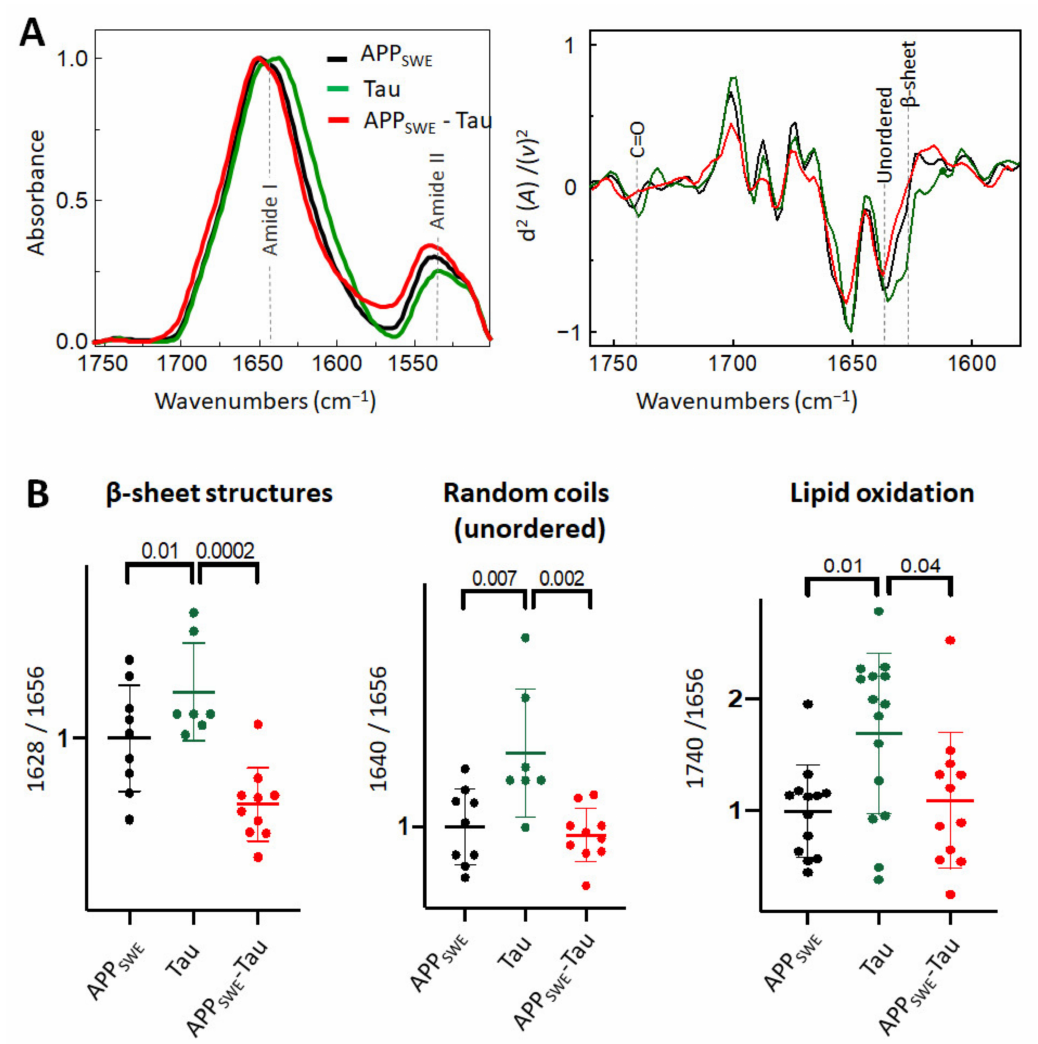
Figure 3. Effect of Tau (P301L) on A β aggregation in A β /Tau cellular model of AD. ( A ) Averaged and normalized infrared absorbance spectra and corresponding normalized second derivatives of N2a-APP SWE , N2a-Tau, N2a-APP SWE -Tau. Dashed lines indicate peak positions ( B ) Statistical analysis of structural changes. One-way ANOVA ( p < 0.01) ± s.d; one dot corresponds to a single cell, n = 7–20 cells per independent measurement, reproduced at least twice. All values were normalized to the control—N2a-APPSWE